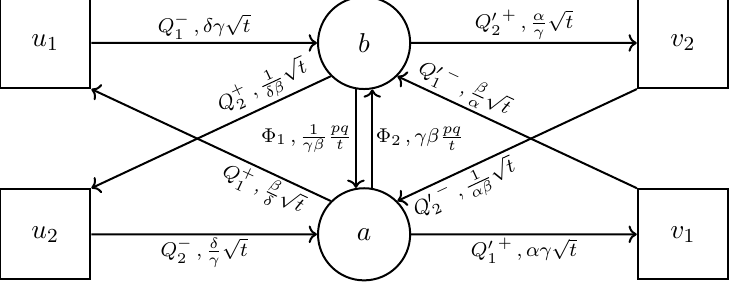
Figure 11. Quiver diagram of the theory associated to a sphere with two minimal punctures and two maximal punctures of colour c